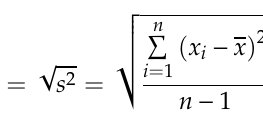
model (ALM) and elastic actuator line model (EALM) at 11.4 m/s: ( a ) power; and ( b ) thrust.